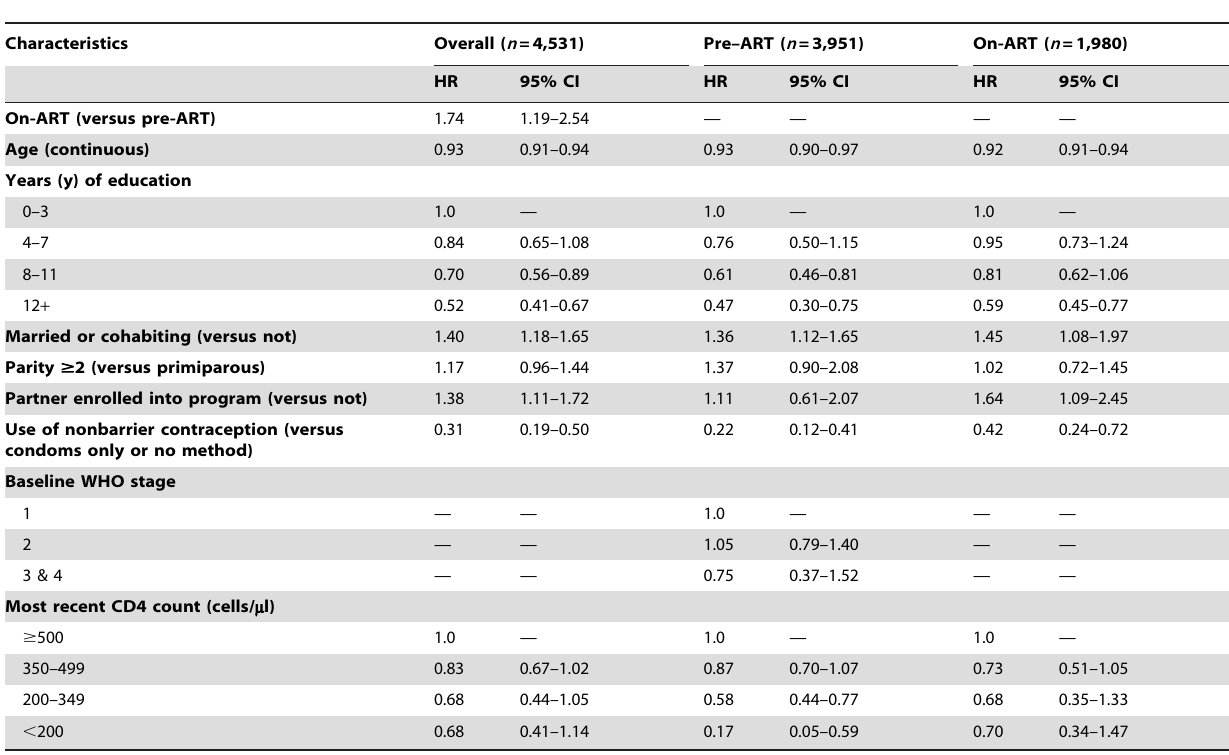
Table 3. Cox’s proportional hazards models examining the association between ART and incident pregnancy, presented as adjusted HRs with 95%